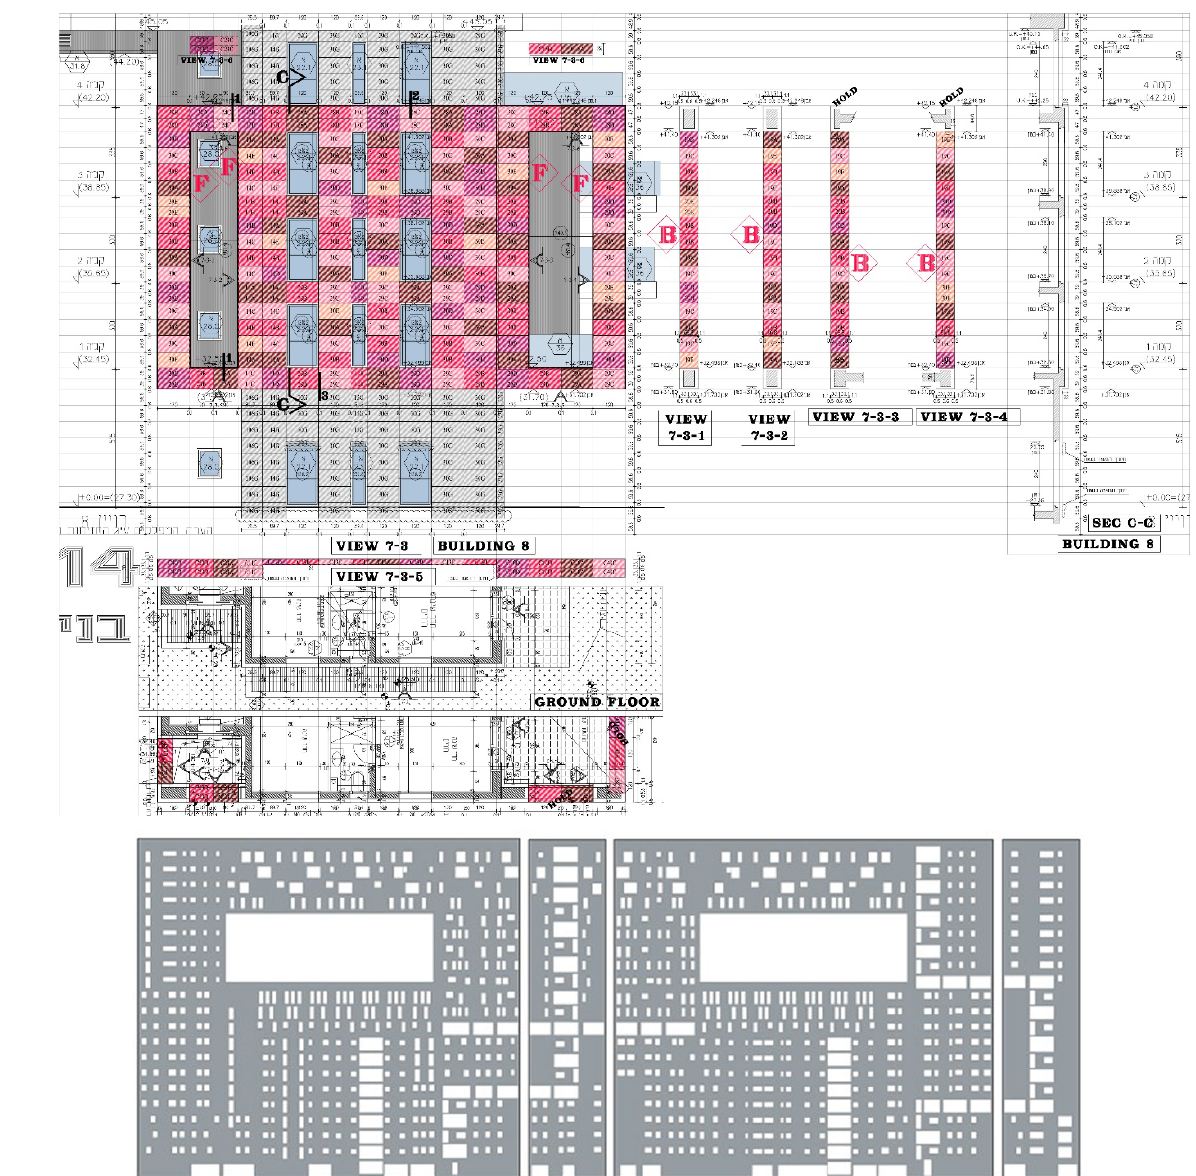
Figure 7. Up: The HH’s carefully designed tiles pattern, using grasshopper software. Source: K. Braz private collection (2018). Down: Mirador’s ‘dress’ packaging ‘neighborhoods,’ a rigorous façade design method. Source: MVRDV (n.d). packaging element that produces a clear unified form by ‘dressing’ functional elements of housing like apartments and service